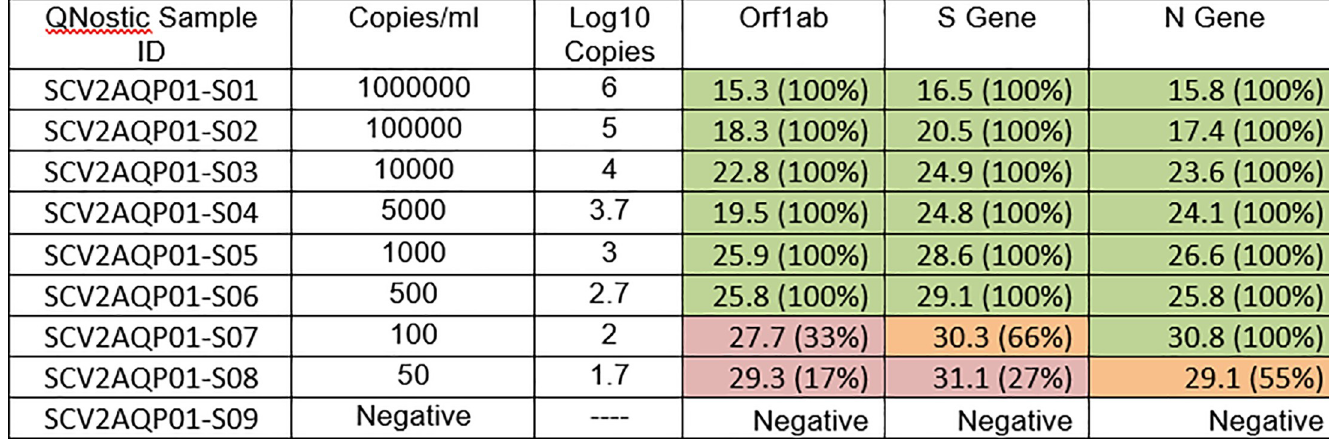
Fig 1. Analytical sensitivity and specificity of the Birmingham Turnkey lab RT-PCR pipeline. This was assessed against the commercial Qnostics SARS-CoV-2 analytical Q-panel– 01. Ct values are a median of 5 independent technical replicates, and figures in parentheses indicate the percentage of replicates returning a PCR positive for that given gene target (Ct < 35). Ct AU : AbbreviationlistshavebeencompiledforthoseusedinFigs 1 and 2 : Pleaseverifythatallentriesarecorrect : , cycle threshold; RT-PCR, reverse transcription PCR; SARS-CoV-2, Severe Acute Respiratory Syndrome Coronavirus 2.